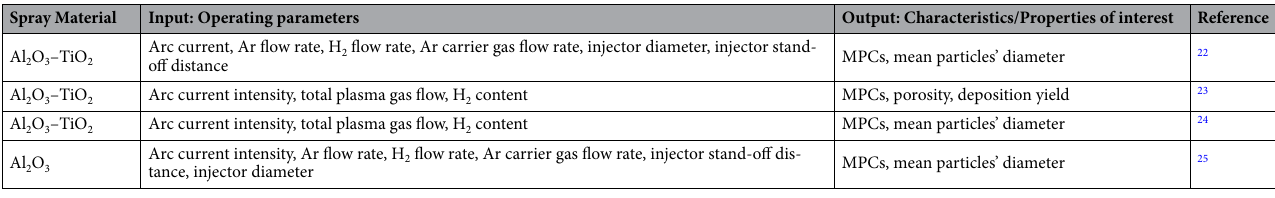
Table 2. Examples of an ANN applied to an